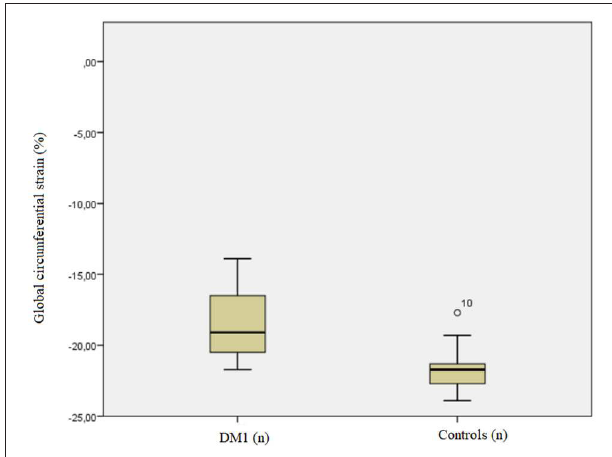
FIGURE 1 | Boxplot showing the comparison of circumferential strain (CS) values in healthy controls vs. myotonic dystrophy (DM) patients.